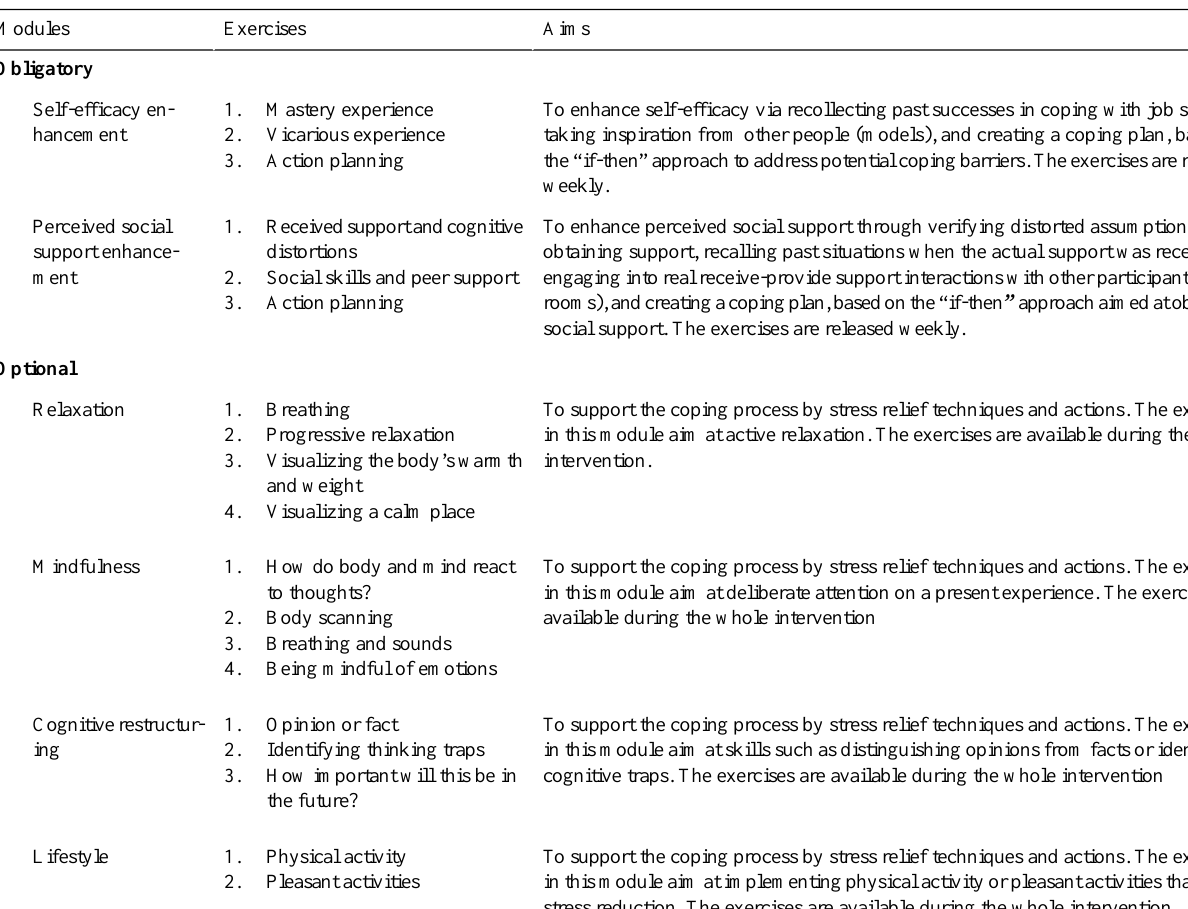
Table 1. The content of the Med-Stress intervention: obligatory and optional